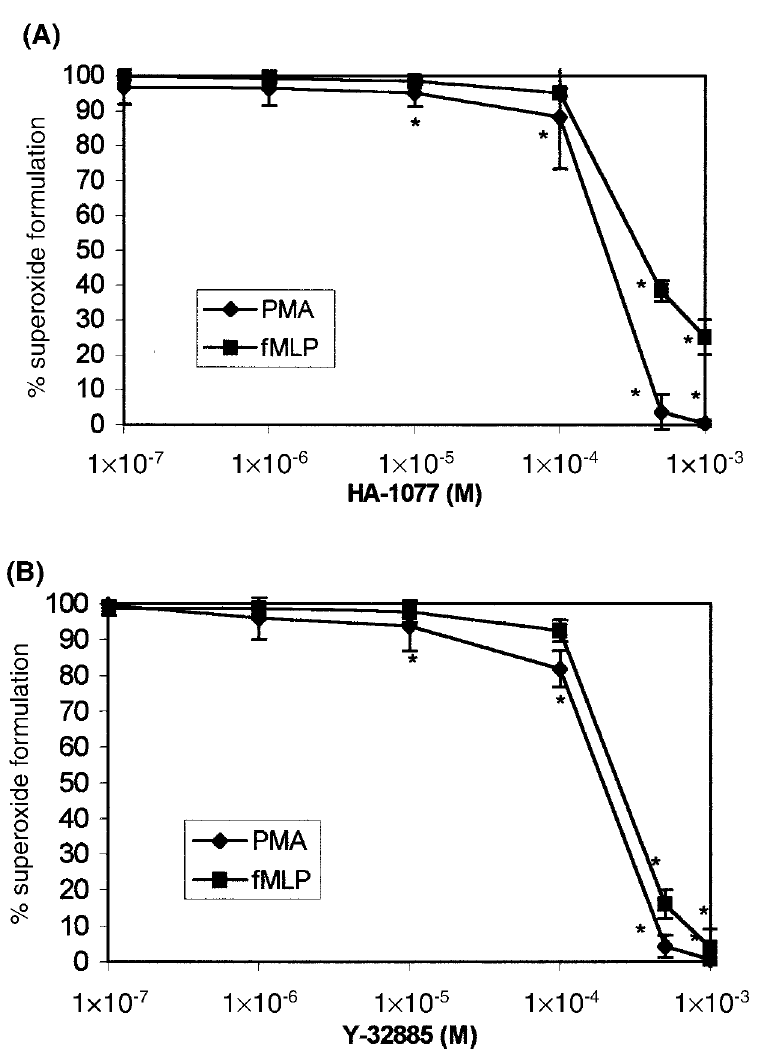
FIG. 2. Action of HA-1077 (A) and Y-32885 (B) on the superoxide production by the human polymorphonuclear. The cells were incubated with various concentrations of the compound for 15min at 37°C. Stimulation was then started by 160nM PMA for 5min or 1 m M fMLP for 10min at 37°C. Cytochrome C was added to the samples to measure the superoxide produced. Results are the mean ± SEM of six experiments. Significant difference versus the reference was evaluated by Student’s t -test, p <